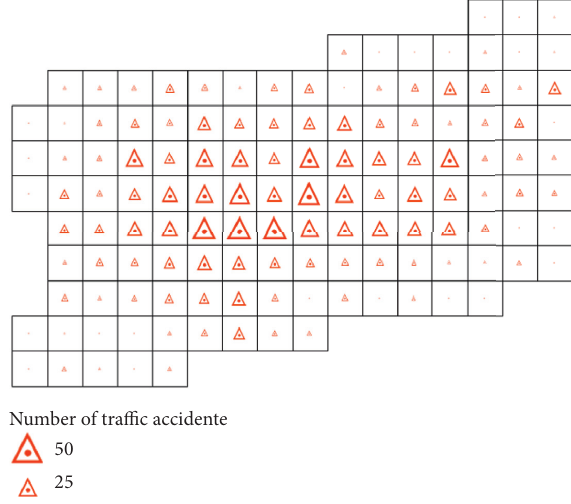
Figure 8: Traffic